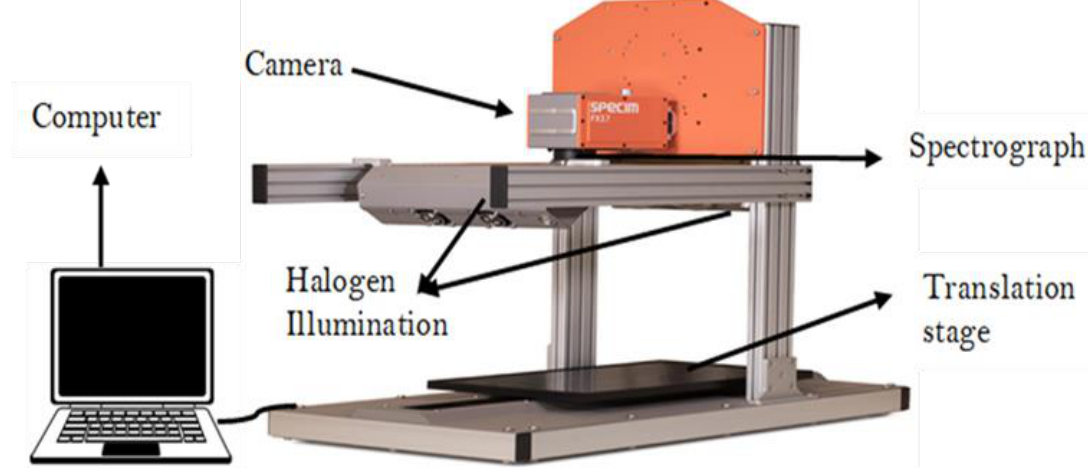
Figure 1. Near infrared (NIR) (900 – 1700 nm) hyperspectral imaging